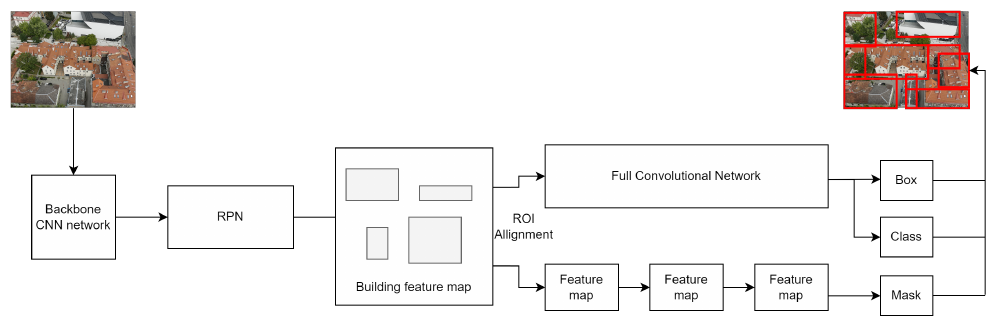
Figure 9. Architecture of the enhanced R-CNN